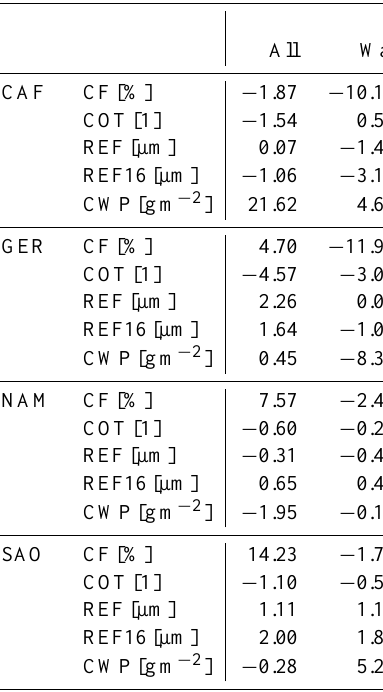
Table 4. Results of the comparison with monthly mean MODIS-Terra cloud optical and microphysical properties for four regions as presented in Fig. 5. Performed for all successfully retrieved cloudy pixels (All), and separately for water cloud pixels (Wat), ice cloud pixels (Ice), and cloudy pixels with uncertain phase (Unc), for cloud properties cloud fraction (CF), cloud optical thickness (COT), effective radius (REF) and cloud water path (CWP). REF16 is the MODIS-Terra effective radius retrieved using the 1.6µm channel. RMSD is root-mean-square